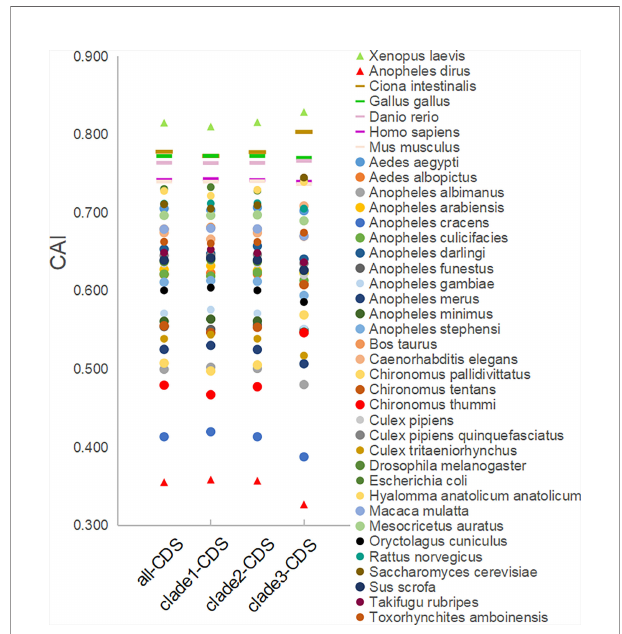
FIGURE 8 | CAI analysis of the EV-A coding sequences against model organisms. CDS stands for the coding sequences of EV-A